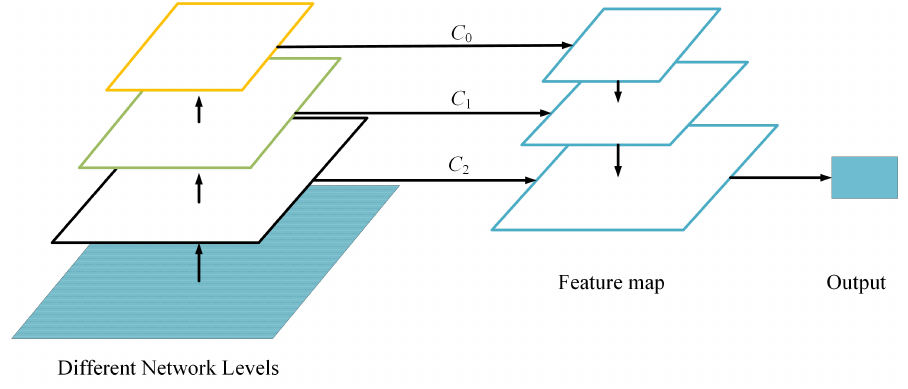
Figure 1. Feature pyramid network